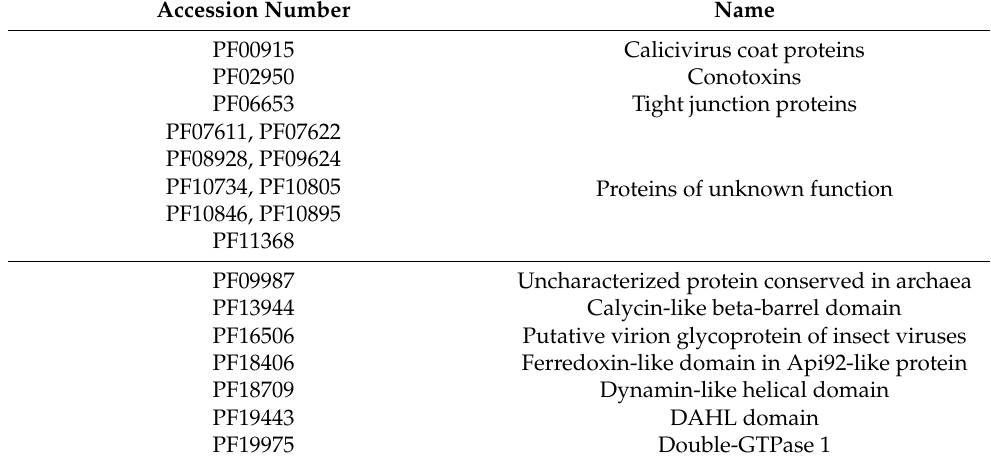
Table 8. Protein family names from the Pfam database whose accession number is used in Table 7 are shown in this